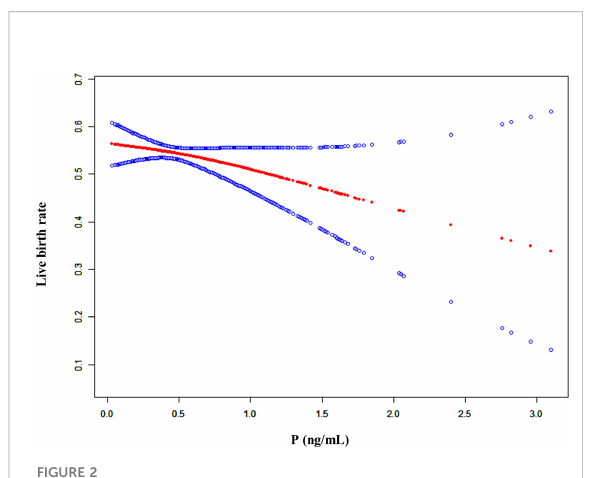
FIGURE 2 A smooth fi tting curve analysis of the relationship between P levels on the hCG day and the live birth rates. The live birth rate of the patients decreased as the P level on the hCG day gradually increased.